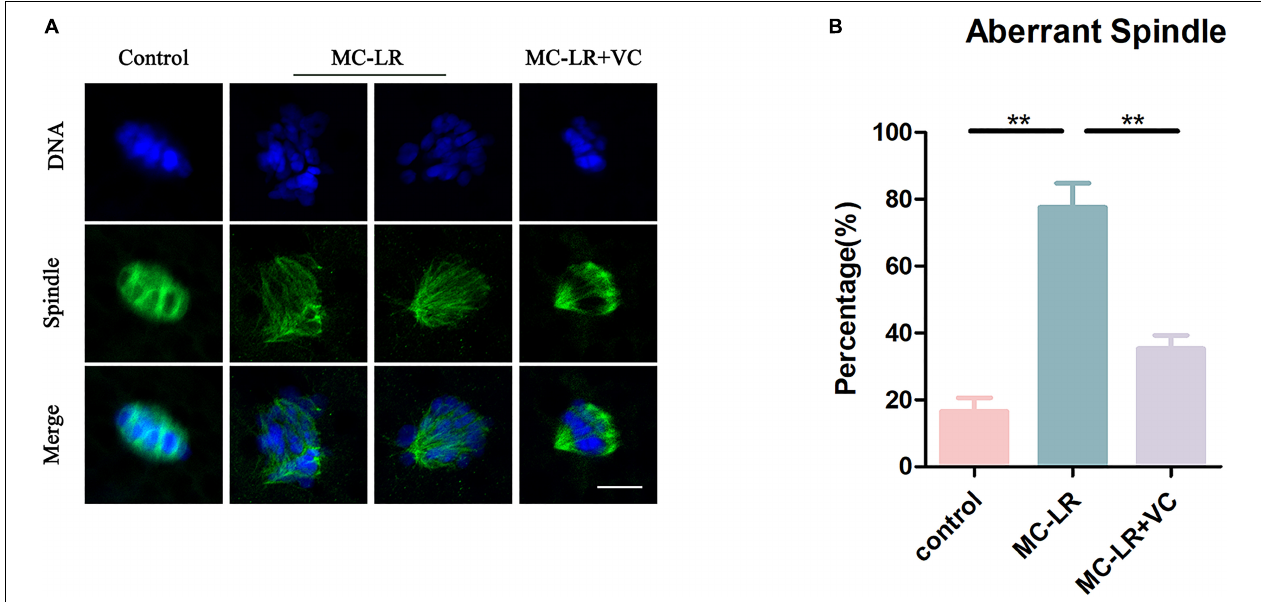
FIGURE 2 | VC protects MC-LR-exposed oocytes from spindle defects. (A) Representative images of spindle morphology and chromosome alignment in the control, MC-LR-exposed, and VC-rescued groups. Bar = 5 µ m. (B) The rate of aberrant spindles in the control, MC-LR-exposed, and VC-rescued groups. ** p < 0.01.